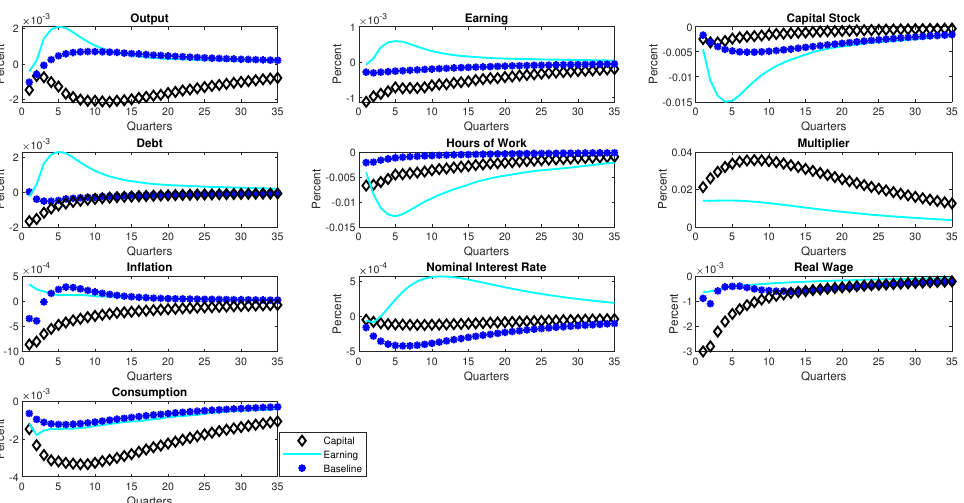
Figure 3. Impulse Responses to a productivity Uncertainty Shock Under Alternative Borrowing Constraints. Notes : The Figure presents the model IRFs of selected variables to a productivity uncertainty shocks. The cyan colored lines represent the model with earnings-based constraint, the black diamonds represent the model with asset-based constraints, whereas the responses with blue stars represent the baseline model without any financial frictions. The parameter sets that generate the IRFs are presented in Table 2. In addition, we set ρ σ = 0.4 and σ = σ A t